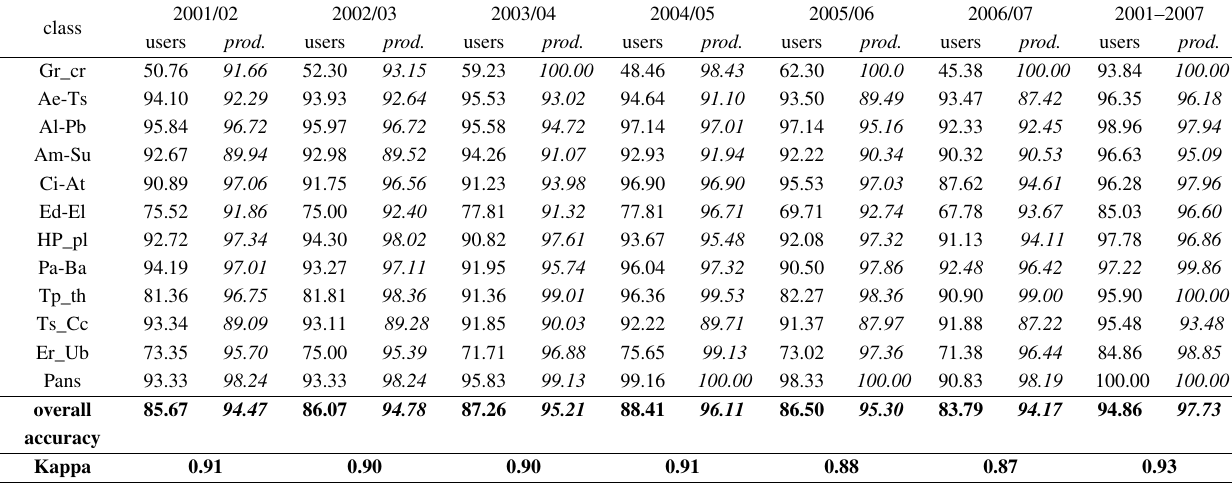
Table 3. User’s-, producer’s and overall accuracies and Kappa coefficients for six annual and the inter-annual classifications.